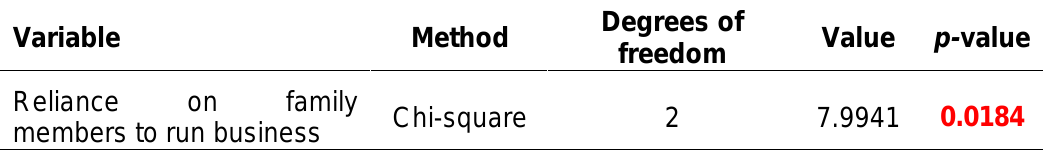
Table 10: Significant Differences Relating to Reliance on Family